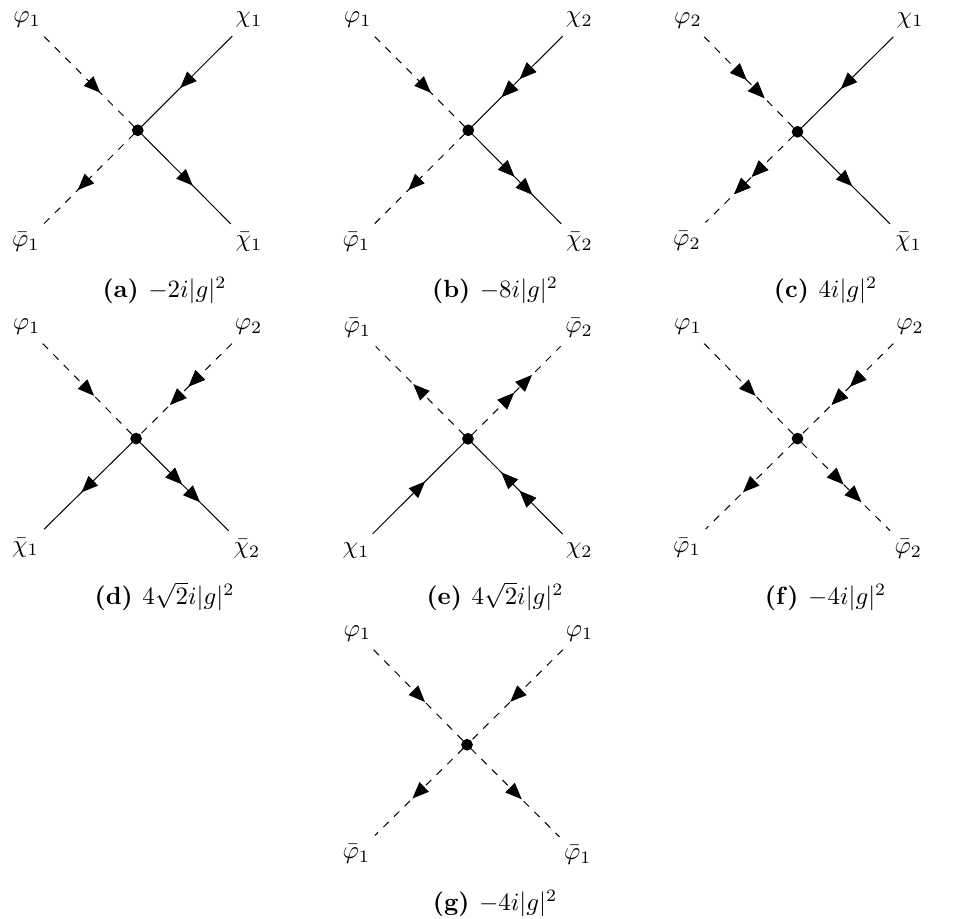
Figure 15. Feynman rules for four-point vertices. Scalars are denoted by dashed lines, while fermions by continuous lines.